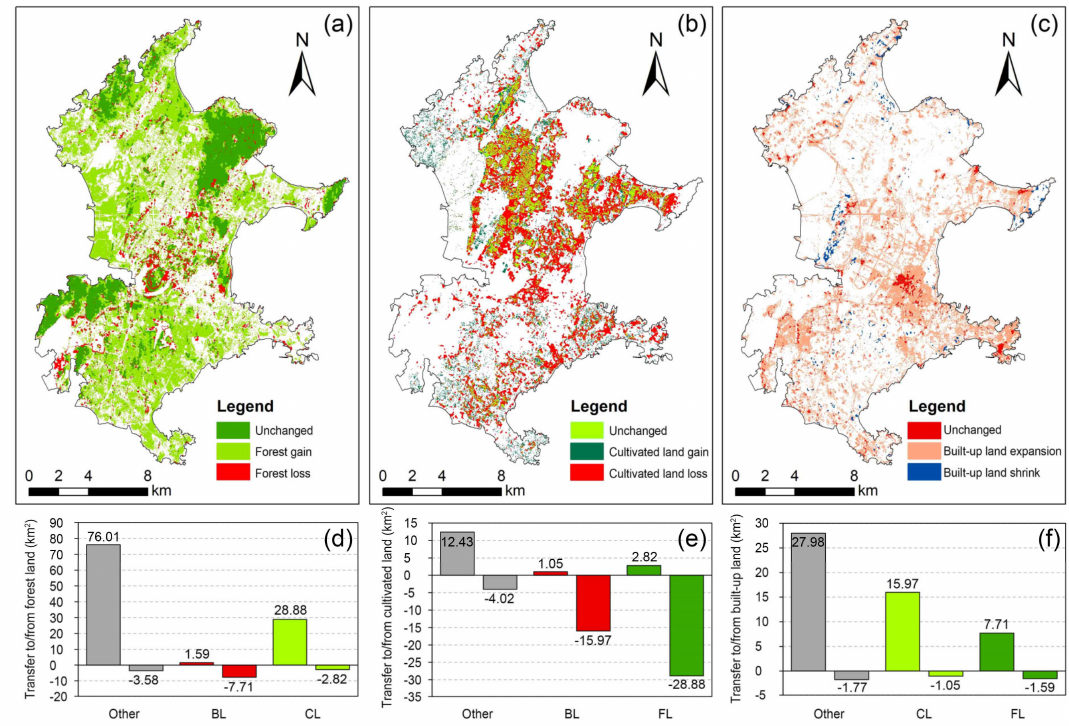
Figure 6. The main land cover types: ( a ) forest change, ( b ) cultivated land change, and ( c ) built-up land change loss and gain between 1990 and 2019 and their conversion. Transfer to / from ( d ) forest land, ( e ) cultivate land, and ( f ) built-up land. Other = sandy land, water, and other land; BL = built-up land, CL = cultivated land, FL = forest